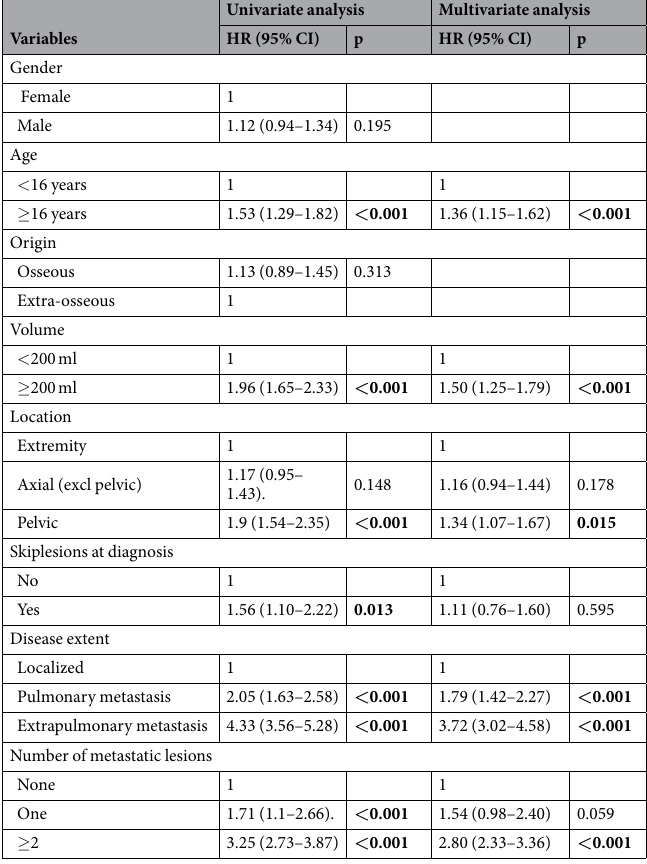
Table 2. Hazard ratio (HR) with corresponding 95% confidence interval (CI) from univariate and multivariate analysis at time of diagnosis (n =